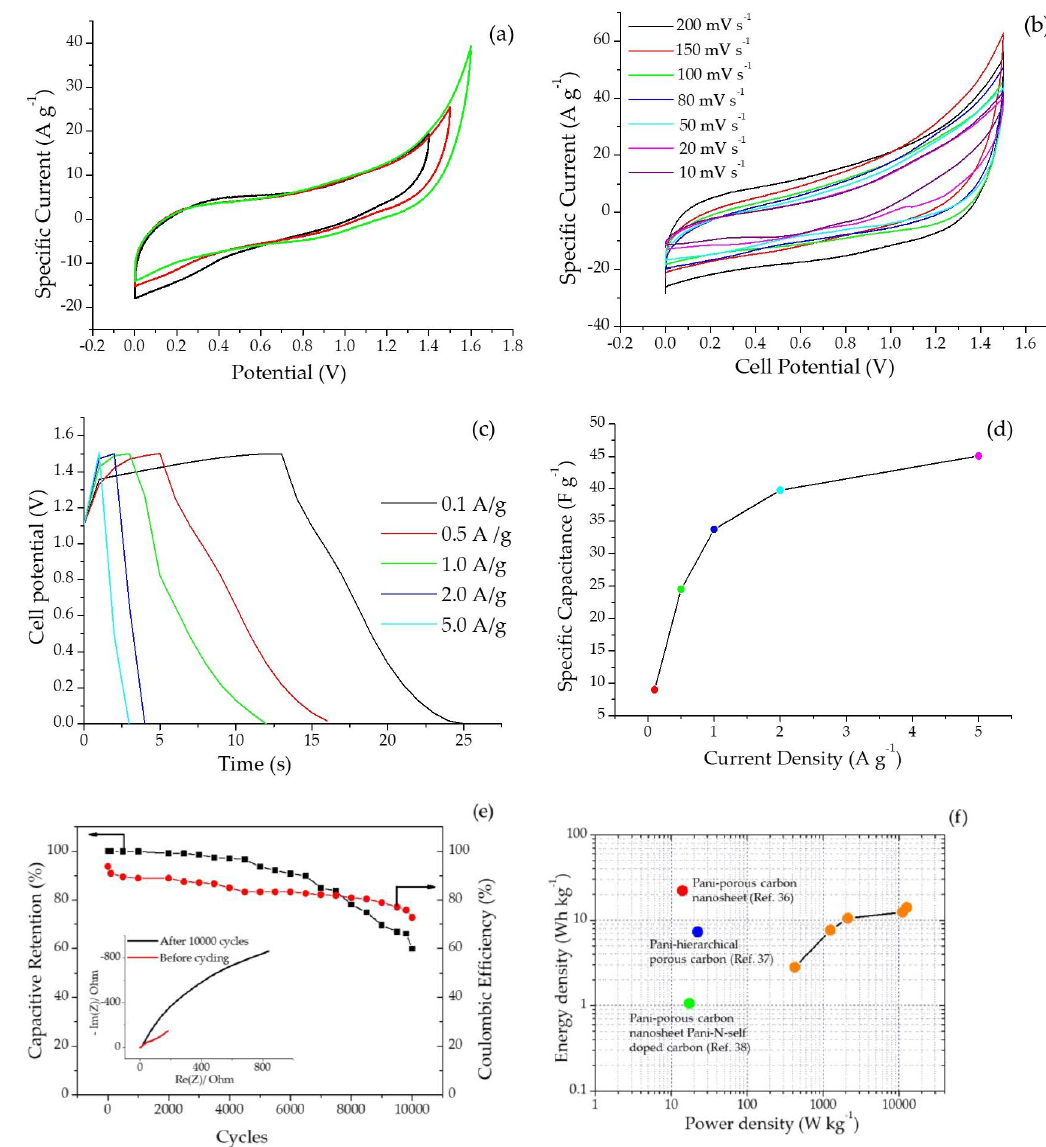
Figure 9. ( a ) Cyclic voltammograms recorded for a symmetric device using Agar-Na 2 SO 4 polymer gel as an electrolyte in different voltage windows, ranging between 0.0 V and 1.4 V, 1.5 V, and 1.6 V, scanned at 50 mV s −1 ; ( b ) cyclic voltammograms at different scan rates, 10, 20, 50, 80, 100, 150, and 200 mV s −1 ; ( c ) GCD curves at different current densities; ( d ) evolution of specific capacitance with respect to the different current densities; ( e ) long-term cycling stability and Coulombic efficiency up to 10,000 continuous charge – discharge cycles at a current density of 0.1 A g −1 , and Nyquist plots recorded before and after the cyclic stability test; ( f ) energy and power density as functions of the current density of the symmetric device assembly.